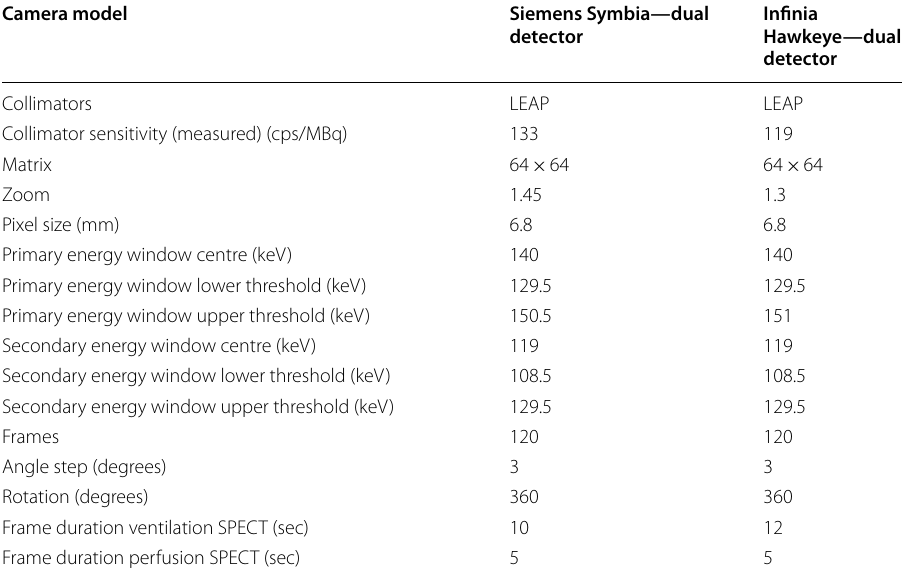
Table 1 SPECT acquisition